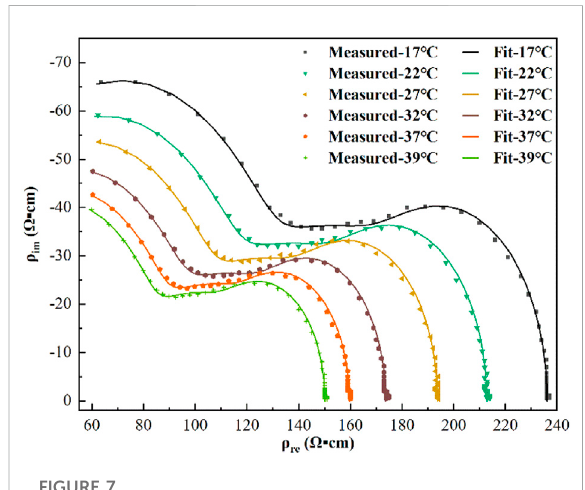
FIGURE 7 Resistivity measurements (points) and third-order function model fi t (lines) at each